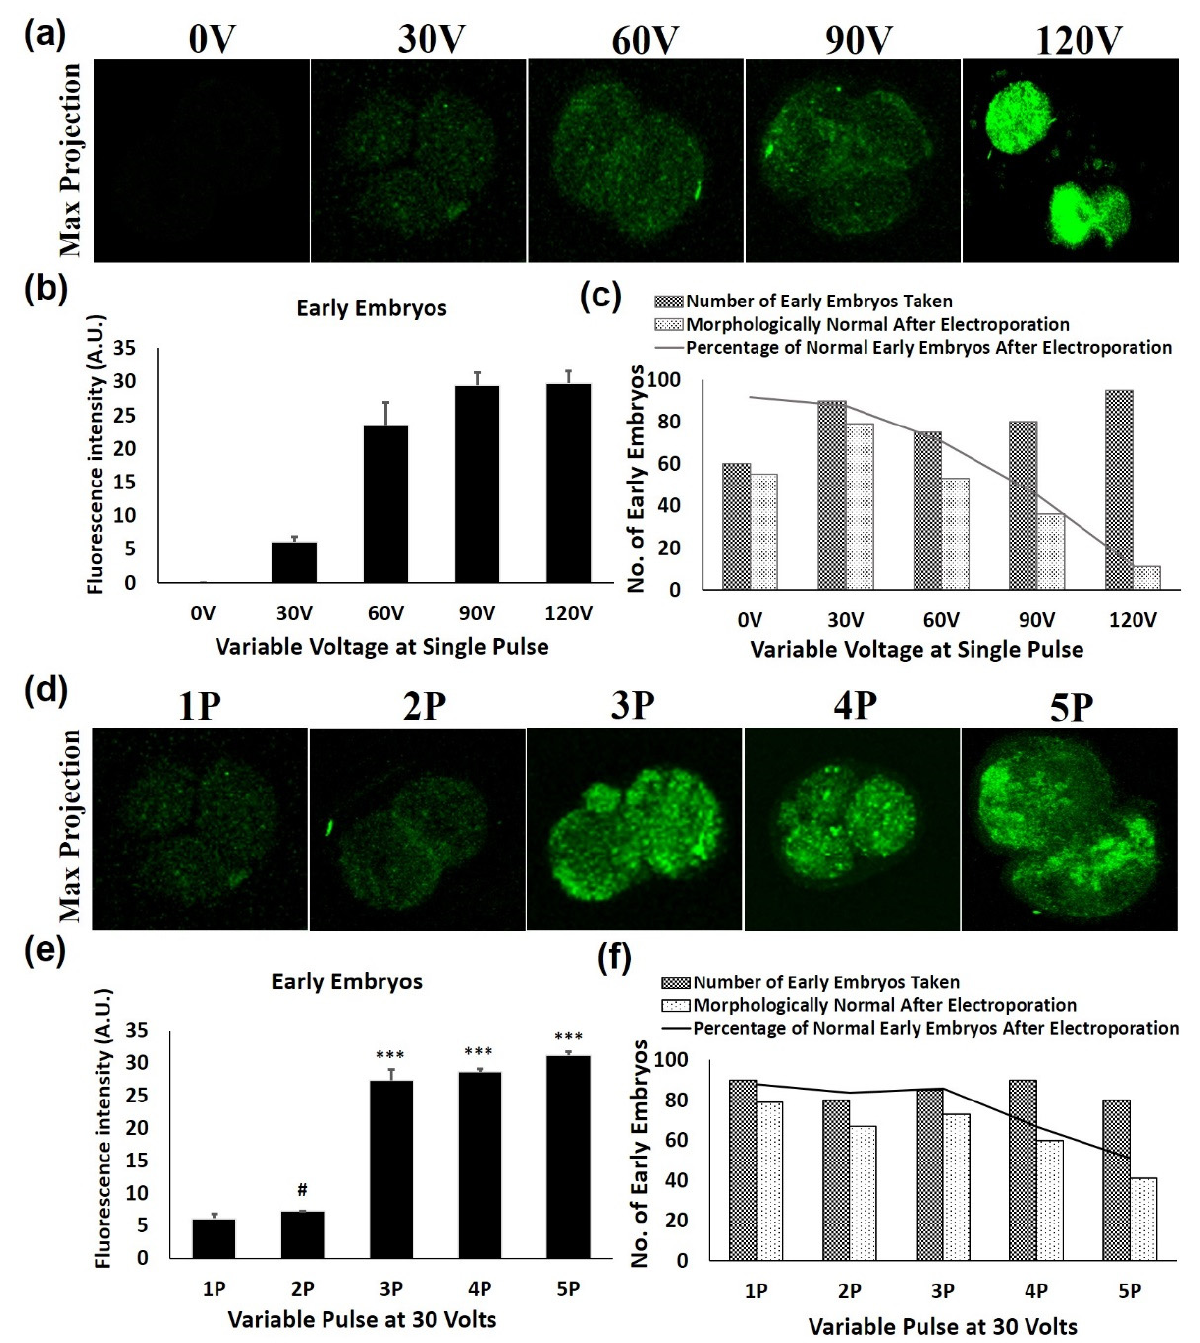
Figure 3. Representative image shows the transfection efficacy of GFP by electroporation in early mouse embryos. ( a – c ) A single pulse of more than 30 volts increased transfection efficiency but compromised the morphology of early embryos. ( d – f ) The multi-pulse 30 volt revealed improved transfection efficiency, but the survival decreased beyond four consecutive pulses (4–5 P). Thus, three pulses (3 P) at 30 V were observed to be optimal conditions for transfection of early embryos by electroporation ( χ 2 = 55.29, df = 8, p < 0.0001). *** p < 0.001 significant differences compared to the single pulse of 30 V. # is non-significant. Original magnification of photomicrographs was ×400.